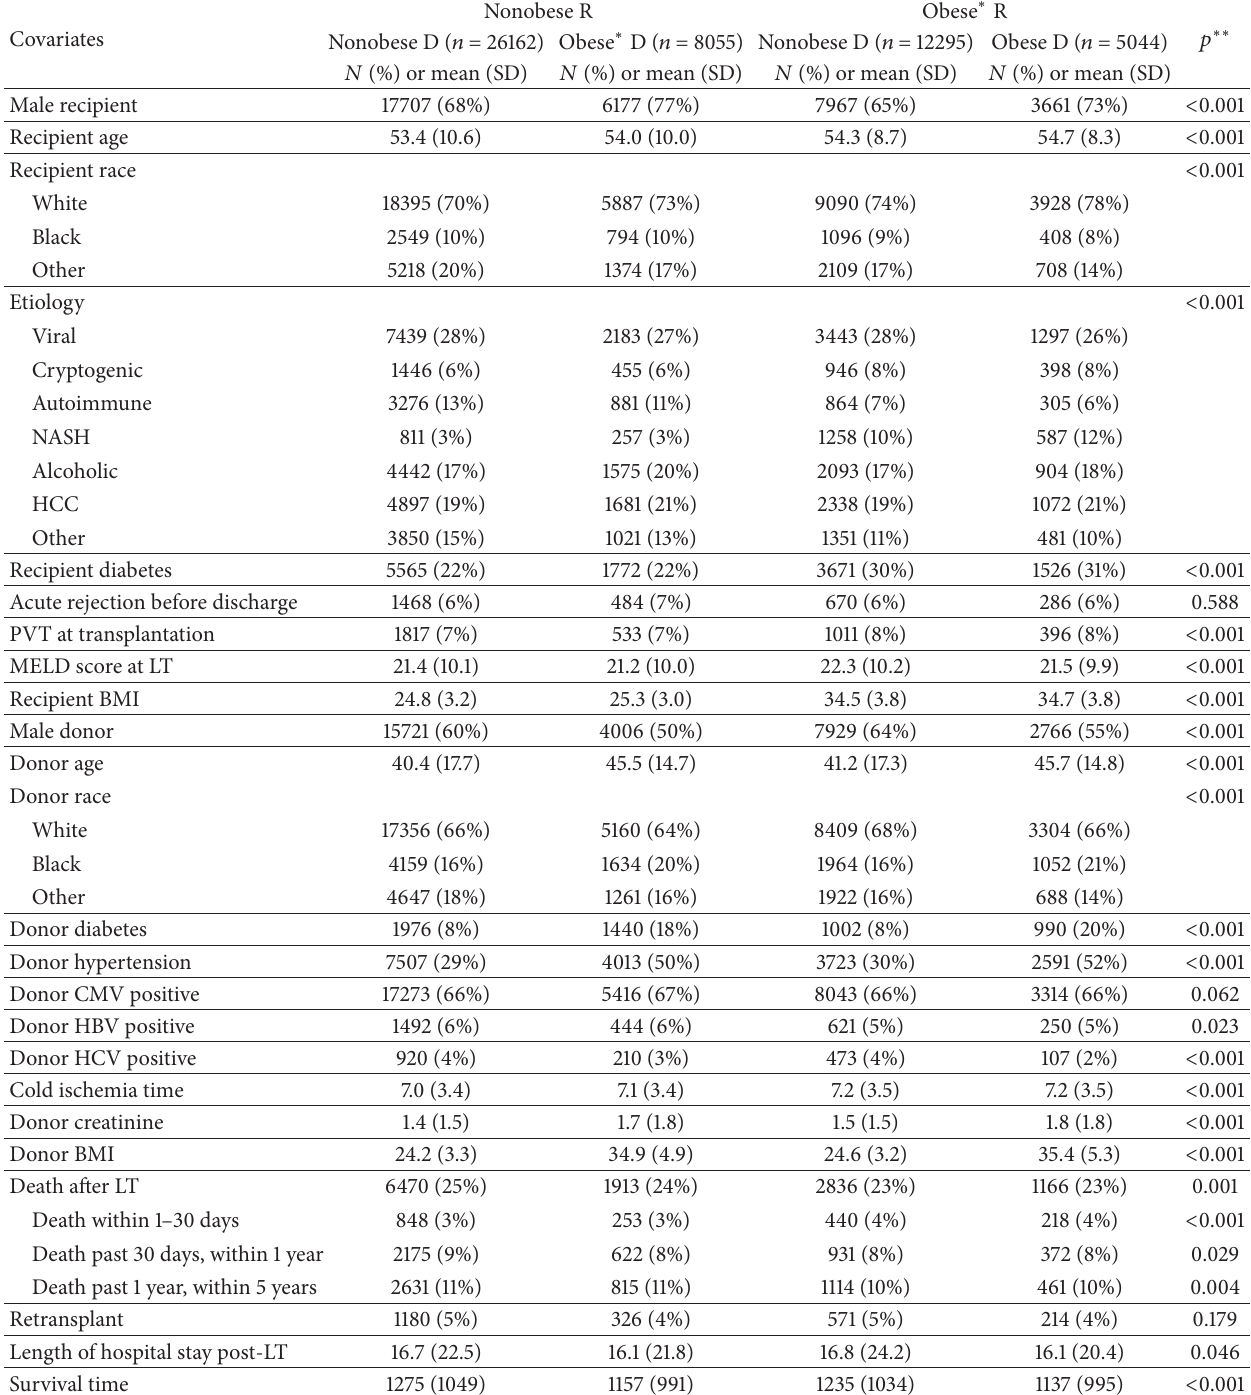
Table 1: Descriptive statistics by recipient donor obesity ( 𝑛 =